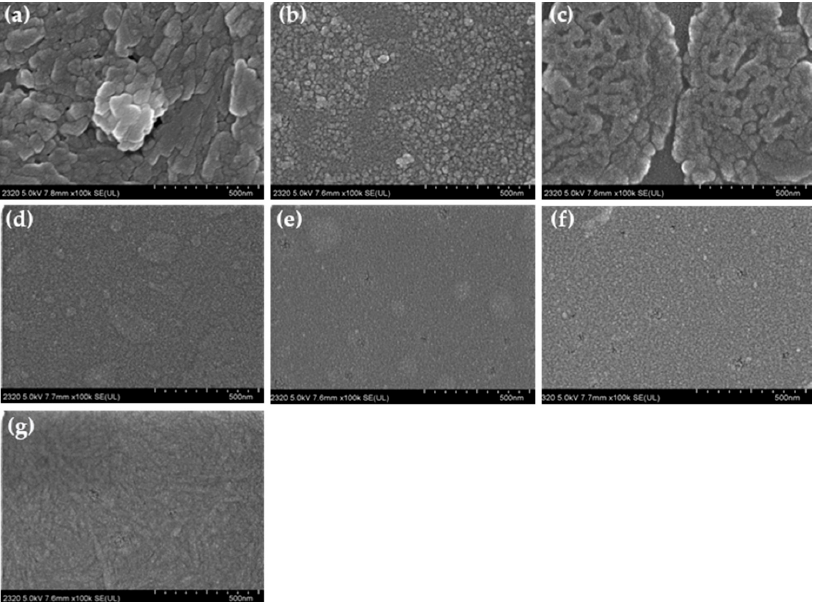
Figure 7. Morphology of each porphyrin film on potassium ion exchanged glass substrate after hydrogen sulfide (1000 ppm) gas exposure, ( a ) TPP, ( b ) TAPP, ( c ) TBPP, ( d ) TCPP, ( e ) THPP, ( f ) TMPP, ( g ) TSPP.